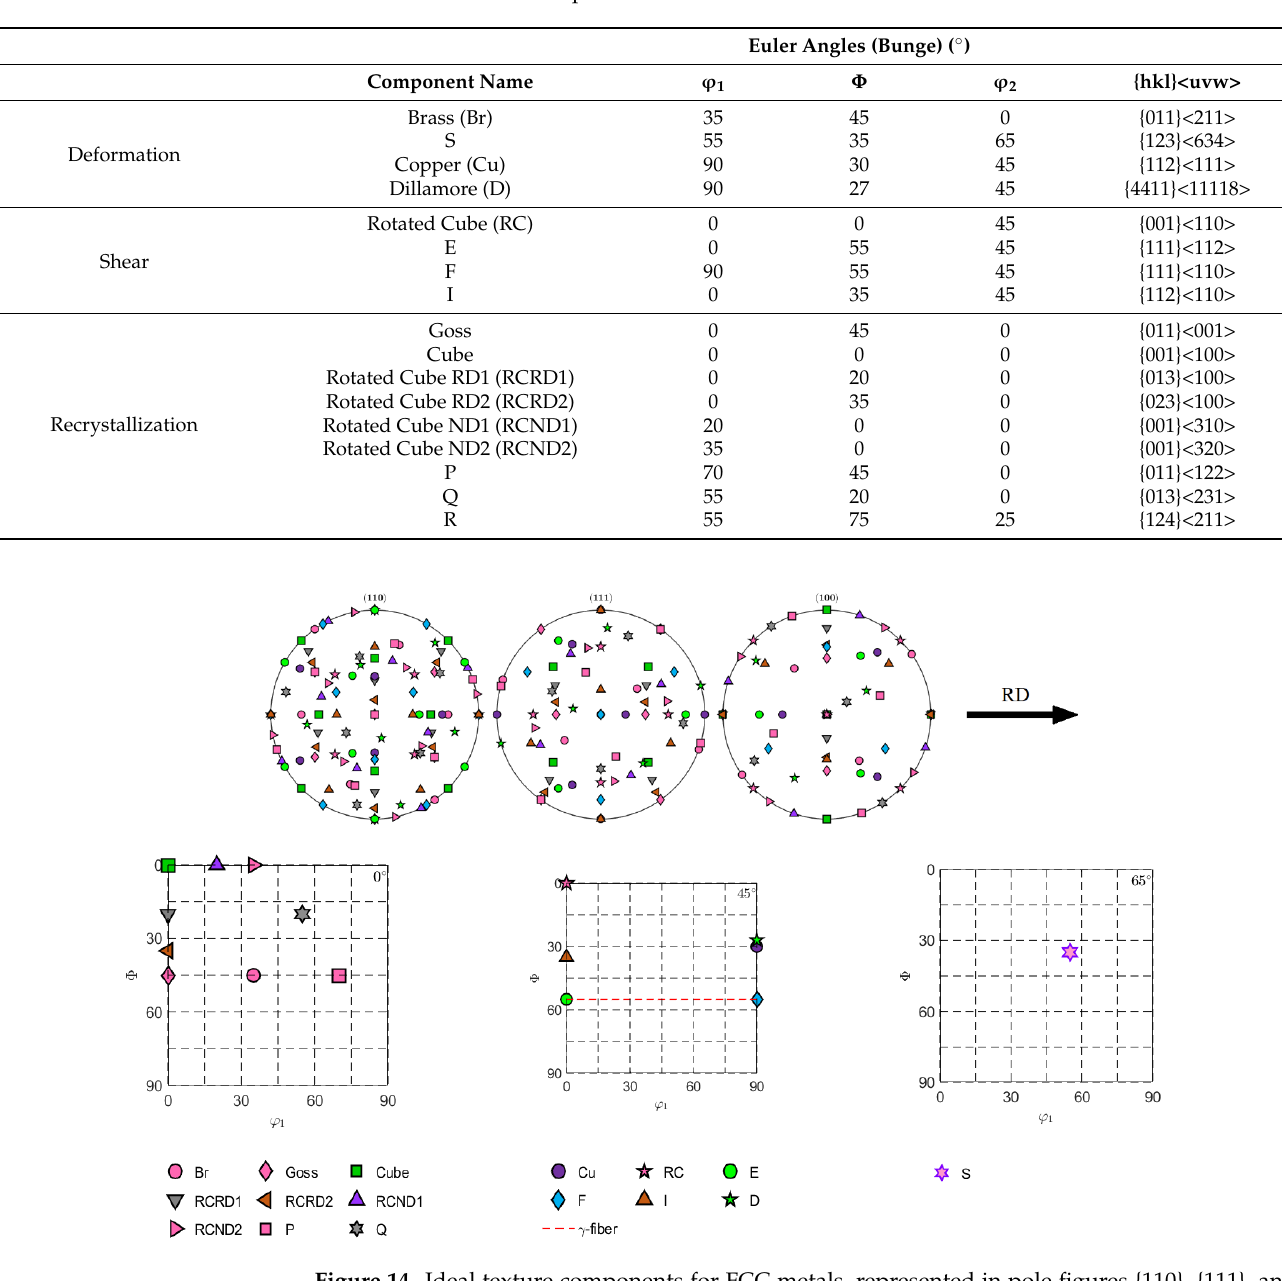
Figure 14. Ideal texture components for FCC metals, represented in pole figures {110}, {111}, and {100}, and ODF sections for φ 2 = 0°, φ 2 = 45°, and φ 2 = 65°. Table 7. Ideal texture components for FCC metals.